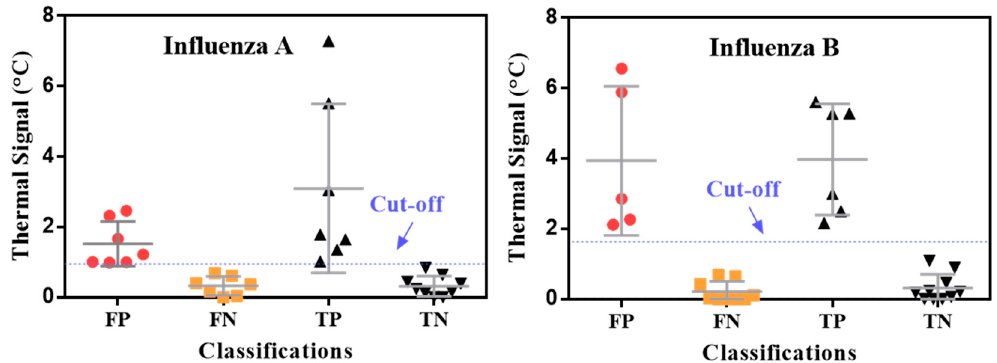
Figure 3. Distribution of thermal contrast signals for influenza A and B. Samples were randomly chosen from 345 clinical LFAs. TP: true positive; TN: true negative; FP: false positive; FN: false negative.